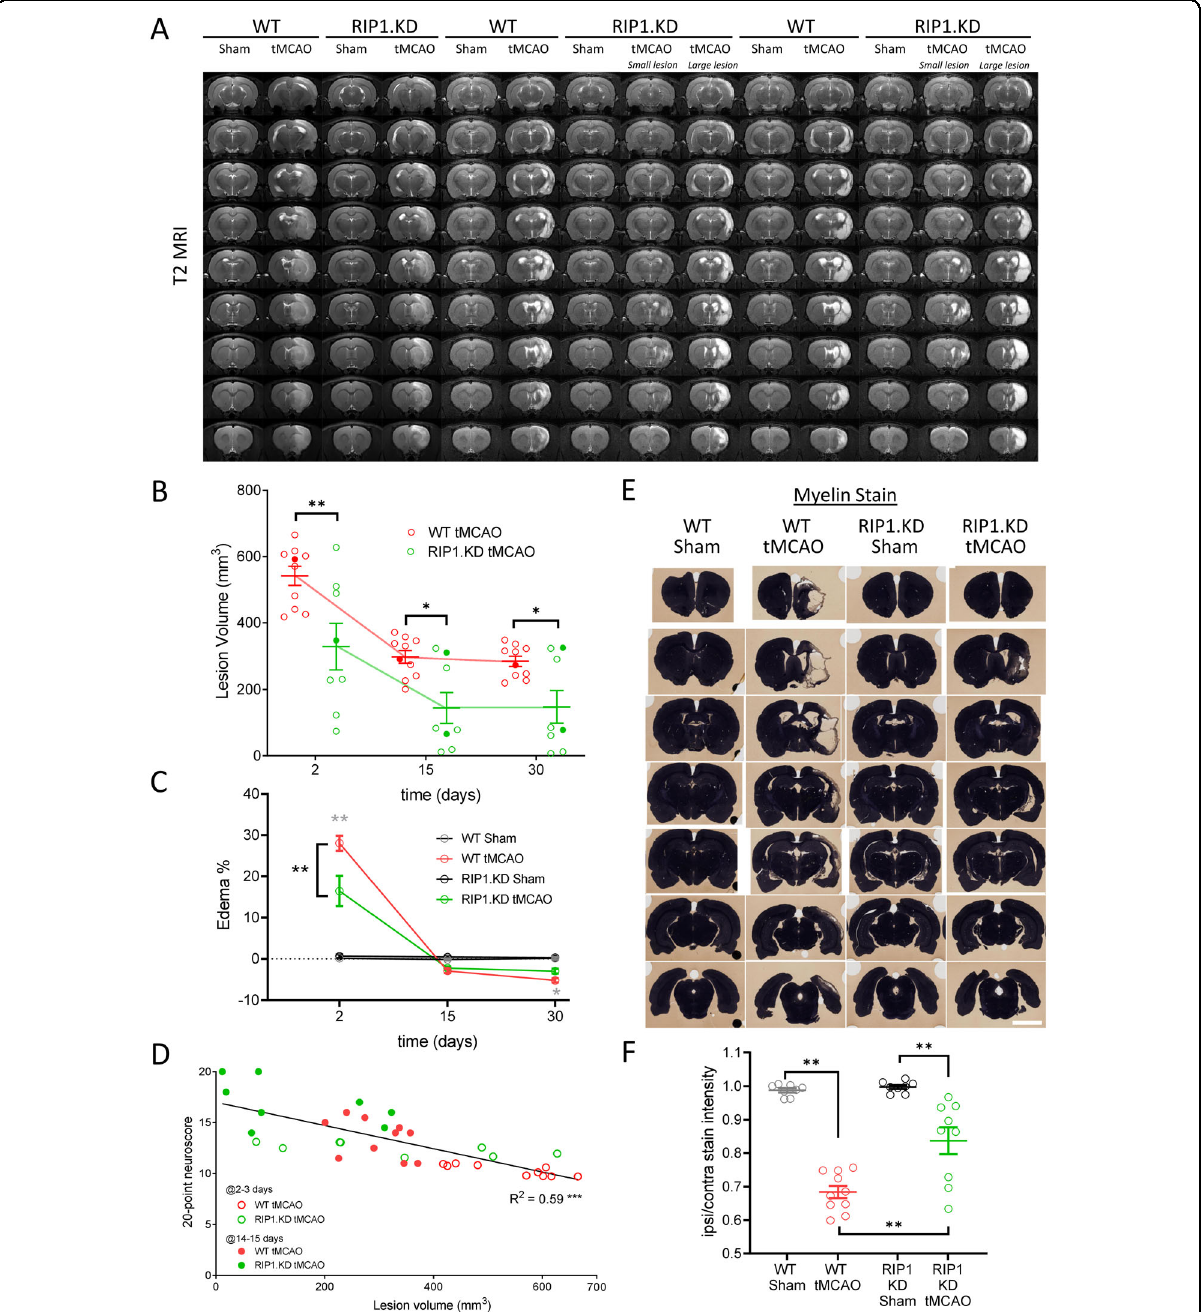
Fig. 3 Genetic inactivation of RIP1 kinase activity preserves tissue integrity following ischemic brain injury. A T2-MRI imaging in WT and RIP1 KD rats following tMCAO surgery. Representative images at days 2-, 15-, and 30 post-tMCAO are shown. In groups where there are two clusters with respect to lesion sizes (as in RIP1 KD-tMCAO 15 and 30 days post-tMCAO, B ), representative images from each cluster are separately shown. B Quanti fi cation of lesion size based on blinded volumetric analysis of T2-relaxation time, from ( A ) (longer time correlates with severity of the lesion). The closed symbols correspond to the animals with T2-MRI images shown in ( A ). n = 8 – 10 rats/group. * p < 0.05 and ** p < 0.01 by Two-way ANOVA (Holm-Sidak). C Quanti fi cation of tissue percent area with edema, from ( A ). n = 8 – 10 rats/group. At the indicated time points, ** p < 0.01 between WT- tMCAO and WT-Sham (in gray), and between RIP1 KD-tMCAO and WT-tMCAO (in black) by Three-way ANOVA (Holm-Sidak). D Correlation between 20-point neuroscore and lesion volume at 2 – 3 days (open circles) and 14 – 15 days (closed circles) post-tMCAO, from ( B ) and Fig. 2C. ** p < 0.01 by Spearman test. E Immunohistochemistry by a myelin stain in WT and RIP1 KD rats at 30-days post-tMCAO. Representative images across the brain are shown. Darker color highlights the intact tissue. Scale bar, 5 mm. F Quanti fi cation of the ratio of ipsilateral to contralateral myelin stain intensity, from ( E ). n = 8 – 10 rats/group. ** p < 0.01 by Two-way ANOVA (Holm-Sidak). Data are represented as mean ±